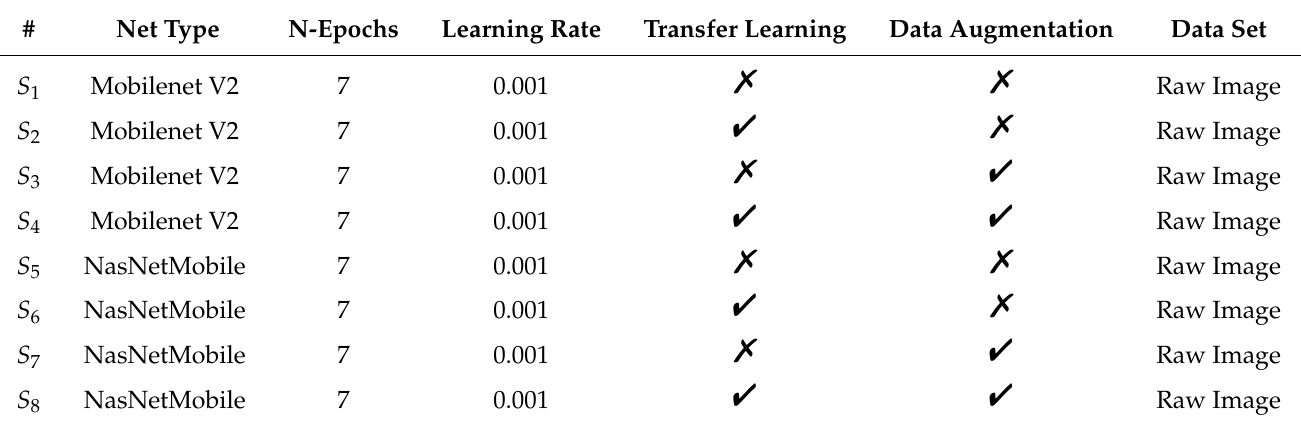
Table 2. Hyperparameters used to configure the neural net used in the experiments.